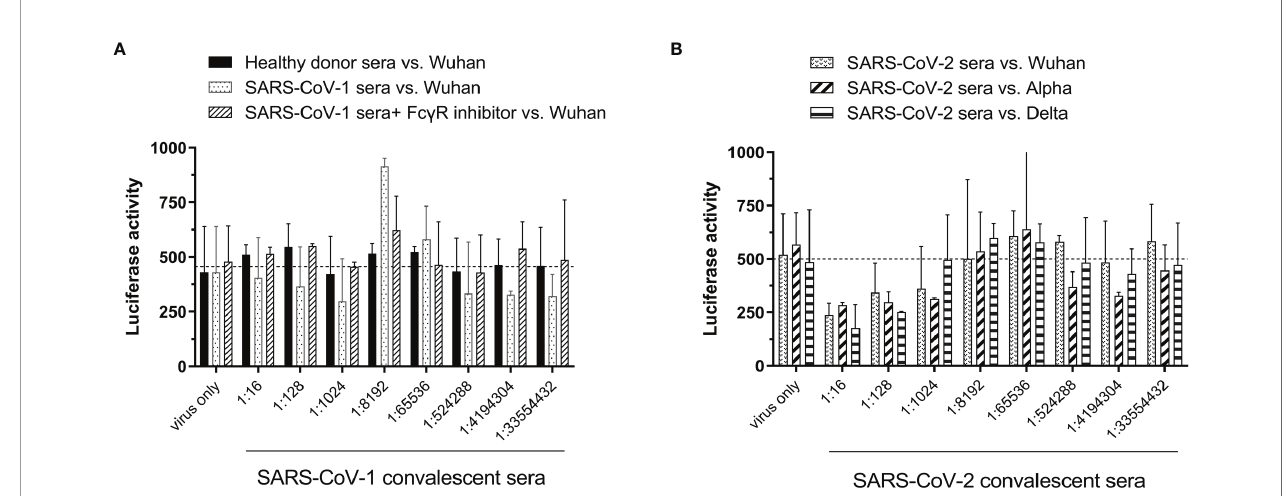
FIGURE 4 | Susceptibility of B lymphoblast Raji cells to infection by SARS-CoV-2 pseudovirus variants under different conditions. (A) SARS-CoV-1 convalescent serum vs. SARS-CoV-2 Wuhan strain. (B) SARS-CoV-2 alpha variant convalescent serum vs. SARS-CoV-2 Wuhan, alpha or delta